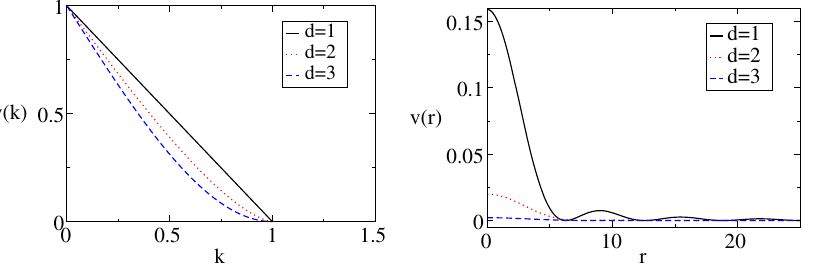
FIG. 5. Left panel: Fourier overlap potential ~ v ð k Þ for the first three space dimensions. Right panel: Corresponding direct-space overlap potentials v ð r Þ , which oscillate but are always non-negative. Here, we set v 0 ¼ K ¼ 1